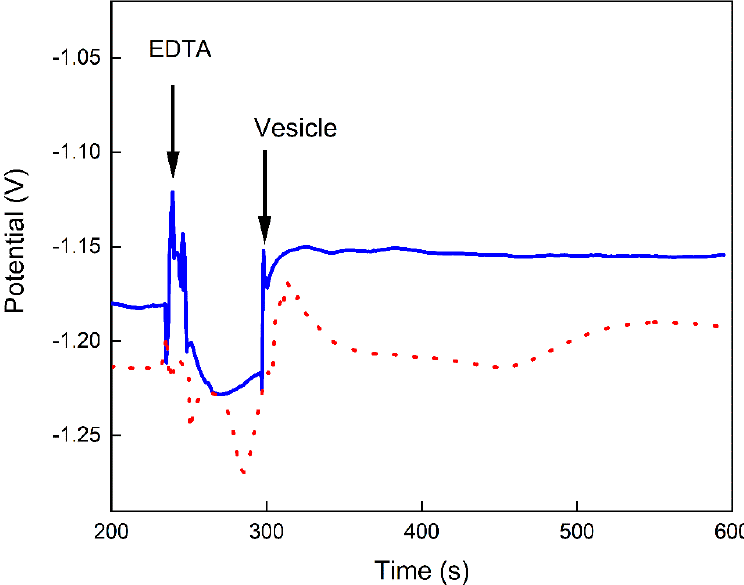
Figure 5. Potential (V) versus time (s) recorded with the BNCD microelectrode in media containing 1 mM Ca 2+ ions in 16 mM Tris-buffer, pH 7.5. After equilibration, 4 µ L of 2.5 mM EDTA were added at 240 s to the microelectrode followed by the addition of 10 µ L of liposomes (0.6 mg/mL of total lipid) (dot line) or proteoliposomes (0.6 mg/mL of total lipid containing 14 µ g/mL of AnxA5) (continuous line) at 300 s. The chelator prevents internalization of Ca 2+ ions by the proteoliposomes and the potential fluctuates in a small range of just a few tens of mV. Due to the presence of the Tris-buffer from the beginning, the potential steps are much smaller than the ones shown in the previous figures. The signal fluctuations are artifacts due to vibrations and turbulences generated by the manual pipetting technique. Despite of such fluctuations, both recordings end at a level of ~30 mV above the baseline, which suggests the absence of ion transport due to the chelating action of EDTA.